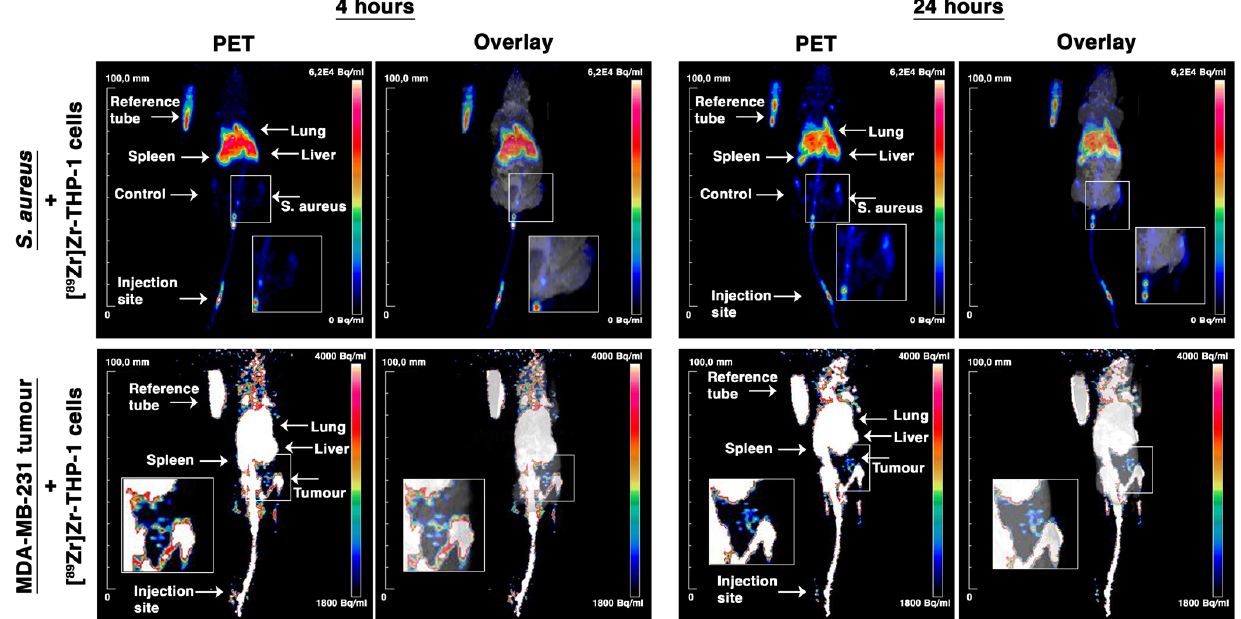
Figure 8. In vivo PET/MRI tracking of [89Zr]Zr-THP-1 cells in Staphylococcus aureus ( S. aureus ) and MDA-MB-231 tumor models. S. aureus or MDA-MB-231 tumor cells were injected intramuscular or subcutaneously injected in BALB/CAnN.Cg- Foxn1nu mice, respectively. Subsequently, ex vivo 89Zr-labeled THP-1 cells ([89Zr]Zr-THP-1, 5–5.8 × 10 6 cells/mouse) were injected intravenously and followed with PET/MRI for 24 h.